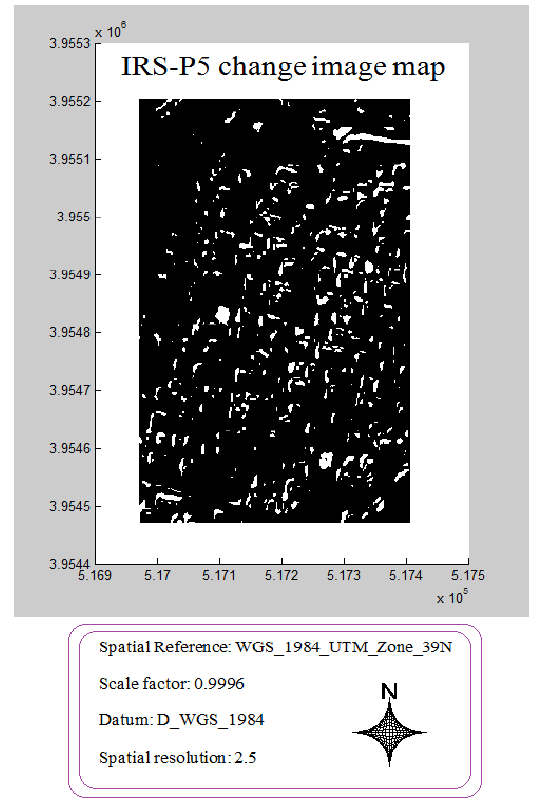
Figure 7. The produced change image map using IRS-P5 satellite images